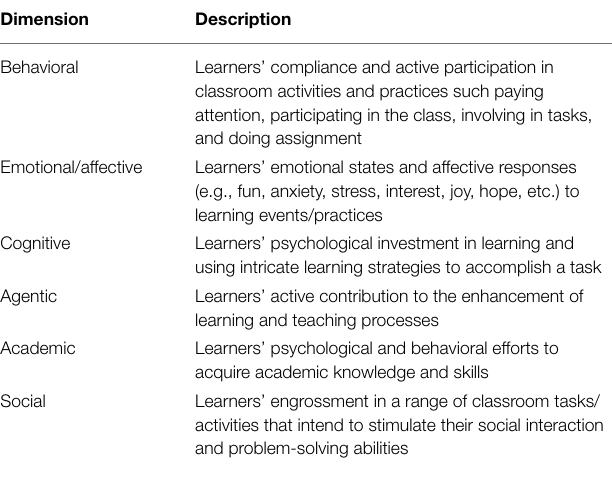
TABLE 2 | The dimensions of student